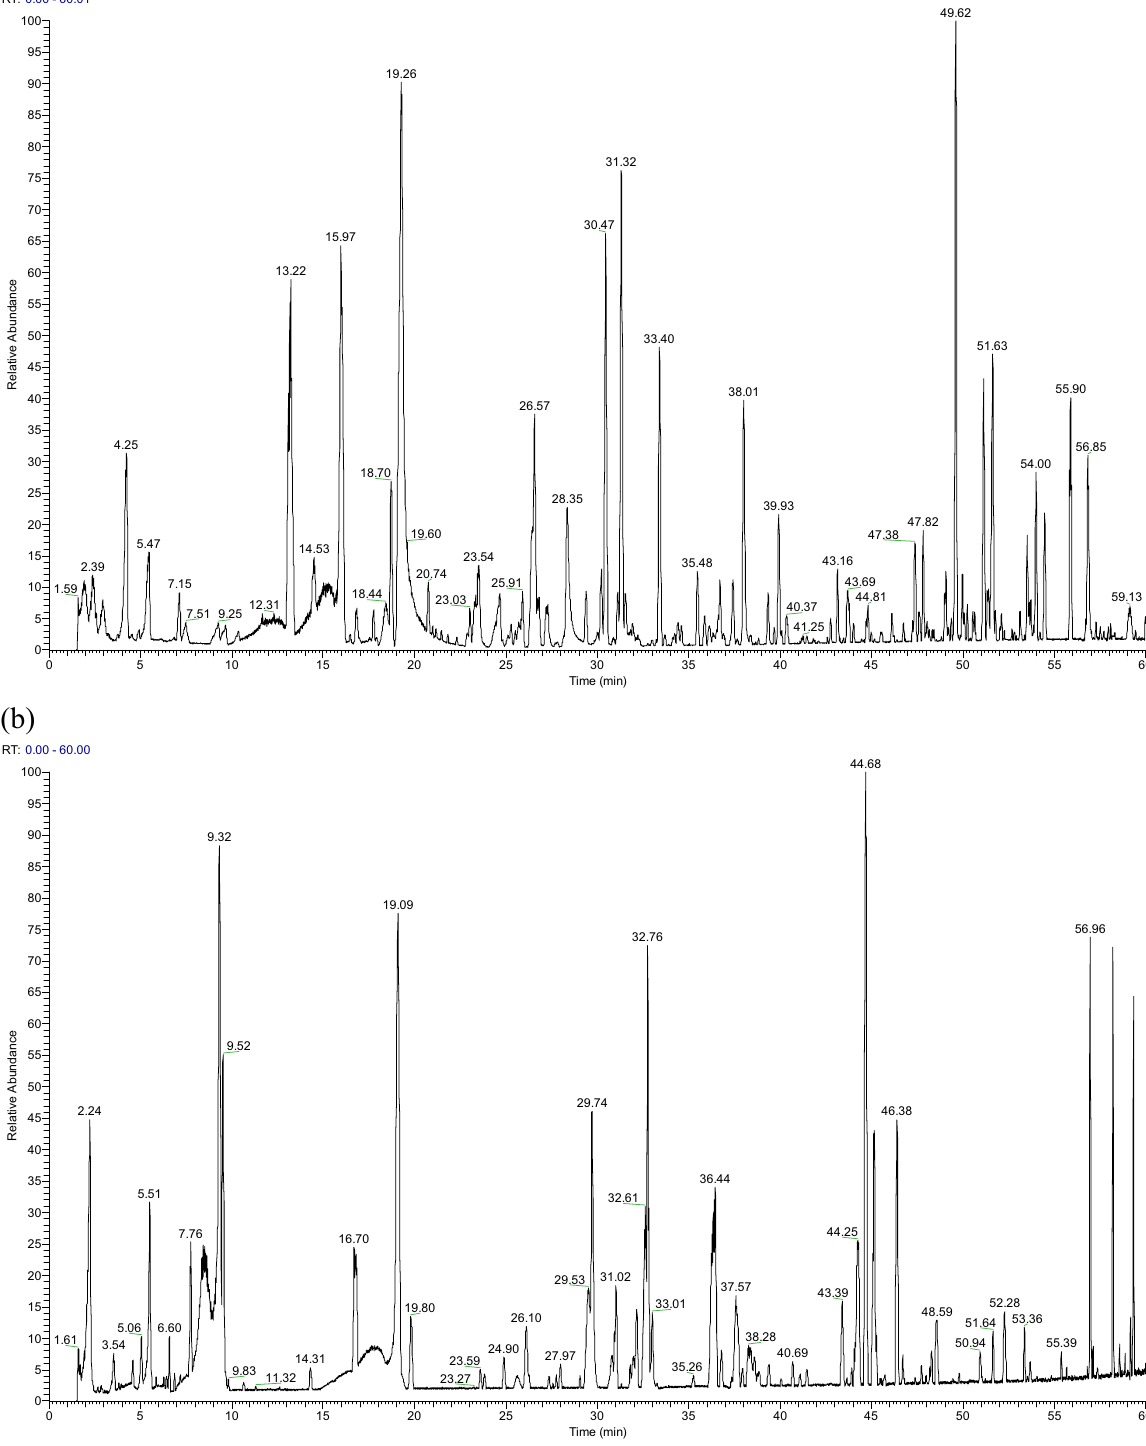
Figure 2. The total ion chromatograms (TICs) of JSHX. ( a ) TIC of JSHX in positive ion mode. ( b ) TIC of JSHX in negative